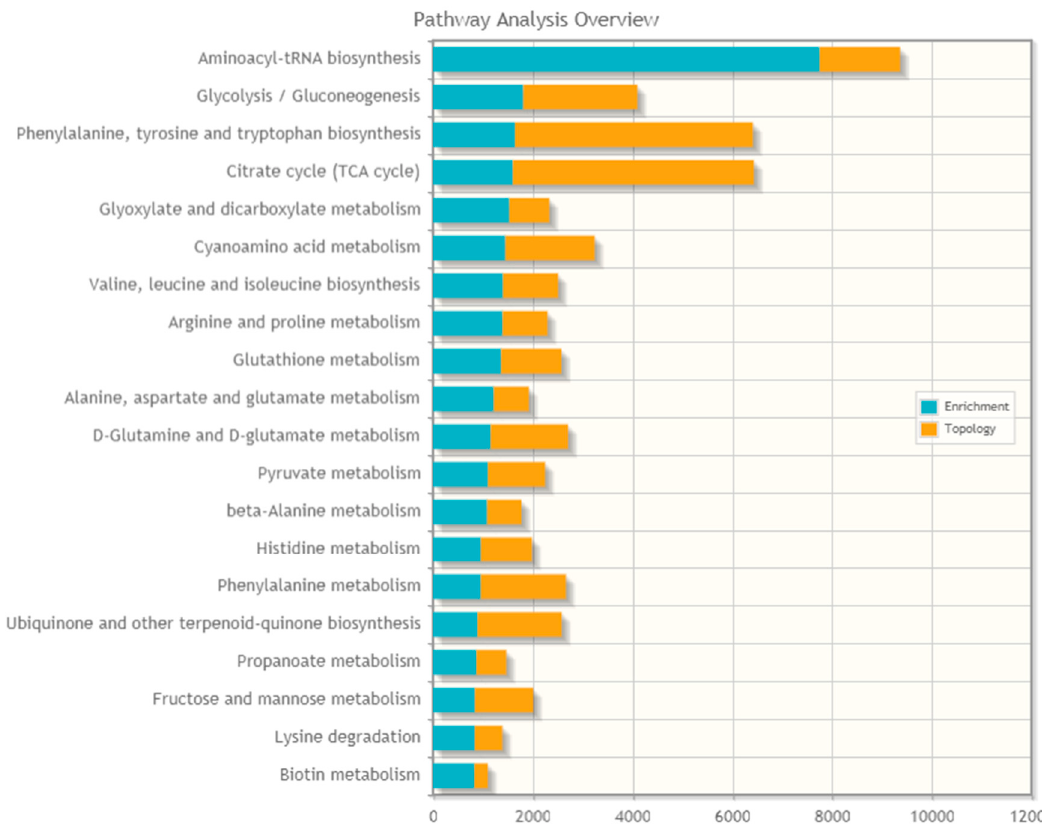
Figure 8. Proteo-metabolomic mapping of glutathionylated proteins in LHON.